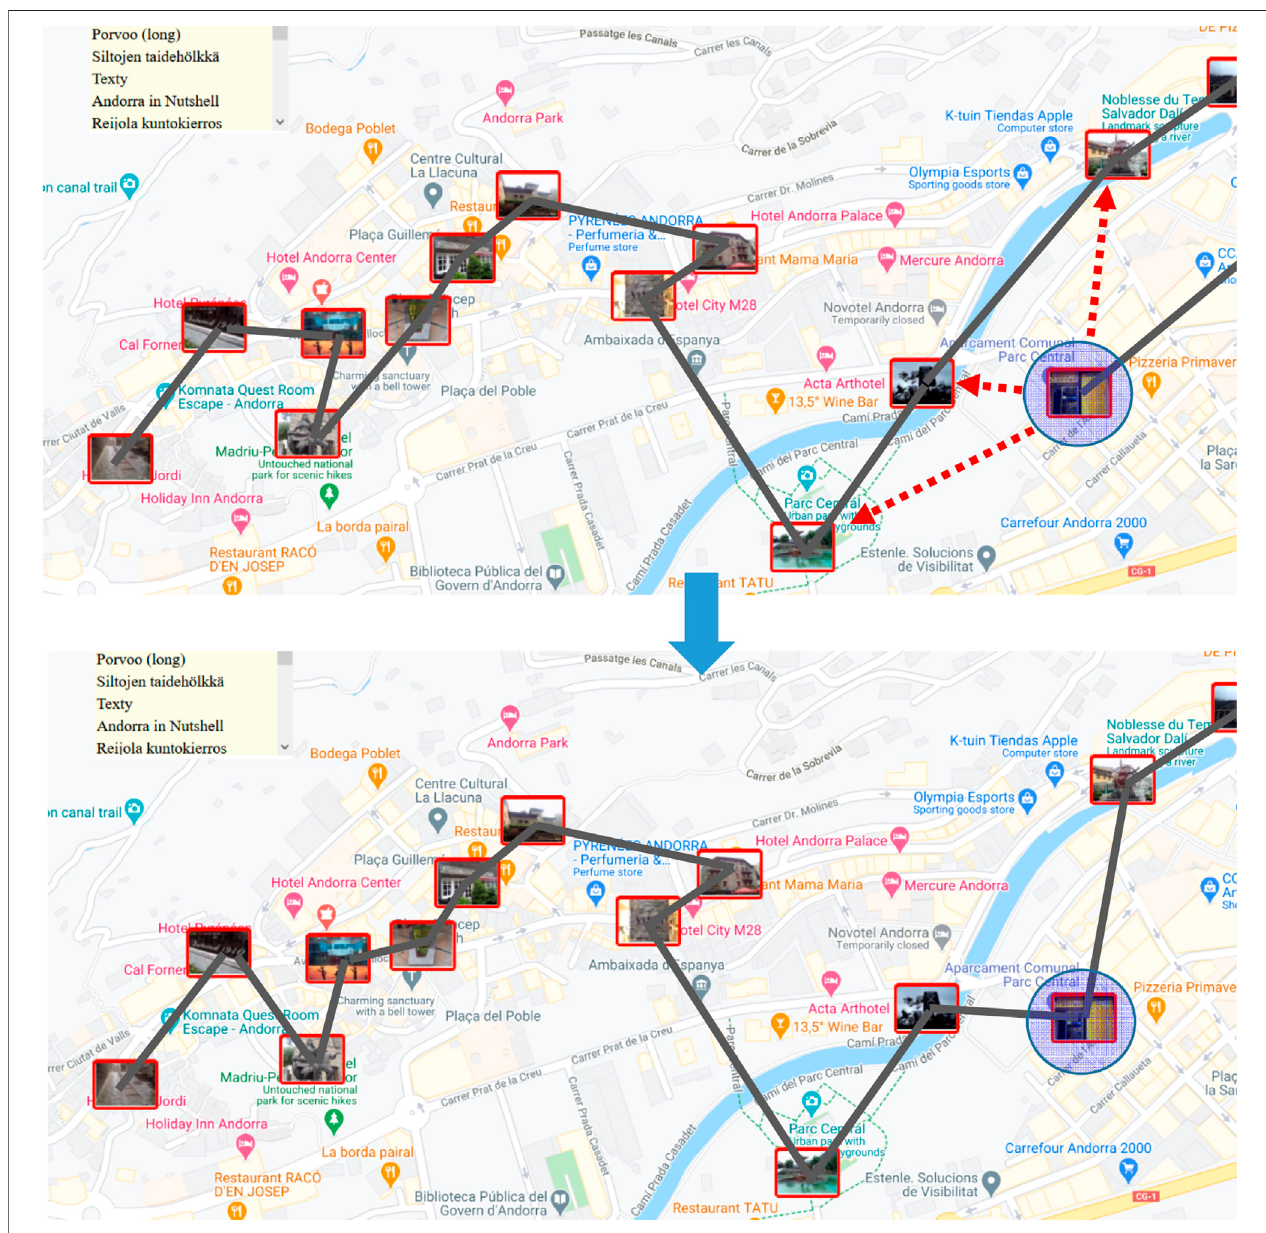
FIGURE3| Localsearchoperatorsshouldconsideronlynearbypointsandlinks.Agiventargethas n − 2 (cid:1) 13newpositions,whereitcouldberelocated.However, only the nearby points (marked by arrows) are worthwhile considering.